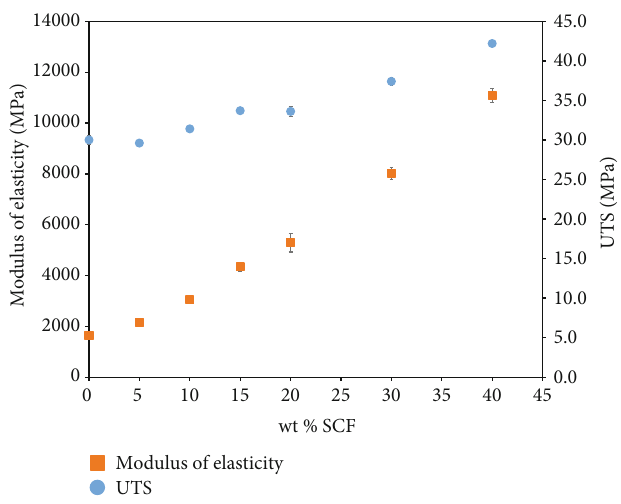
Figure 3: Modulus of elasticity and UTS for di ff erent wt% of SCF (0 – 40wt% of SCF). Table 5: Mechanical properties of neat PP and its composites with 10 – 15 wt% of SCF.